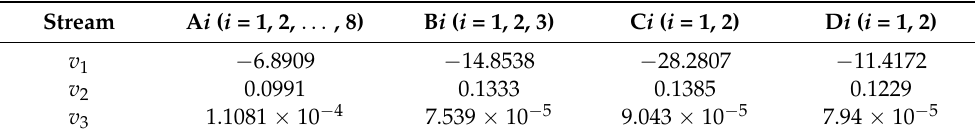
Table 2. Coefficients of temperature-enthalpy correlation for each stream.